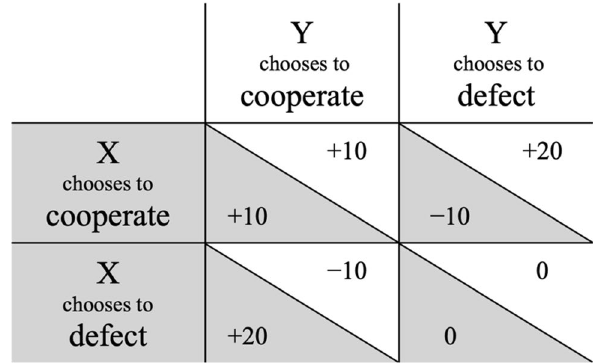
Figure 1. An example for the payoff matrix of a Prisoner’s Dilemma game (in cents). Values on gray backgrounds represent the payoffs of Player X while values on white backgrounds represent the payoffs of Player Y . The Prisoner’s Dilemma game is characterized by a payoff structure in which unilateral defection yields the highest payoff, followed by mutual cooperation which, in turn, yields a higher payoff than mutual defection. Unilateral cooperation yields the lowest